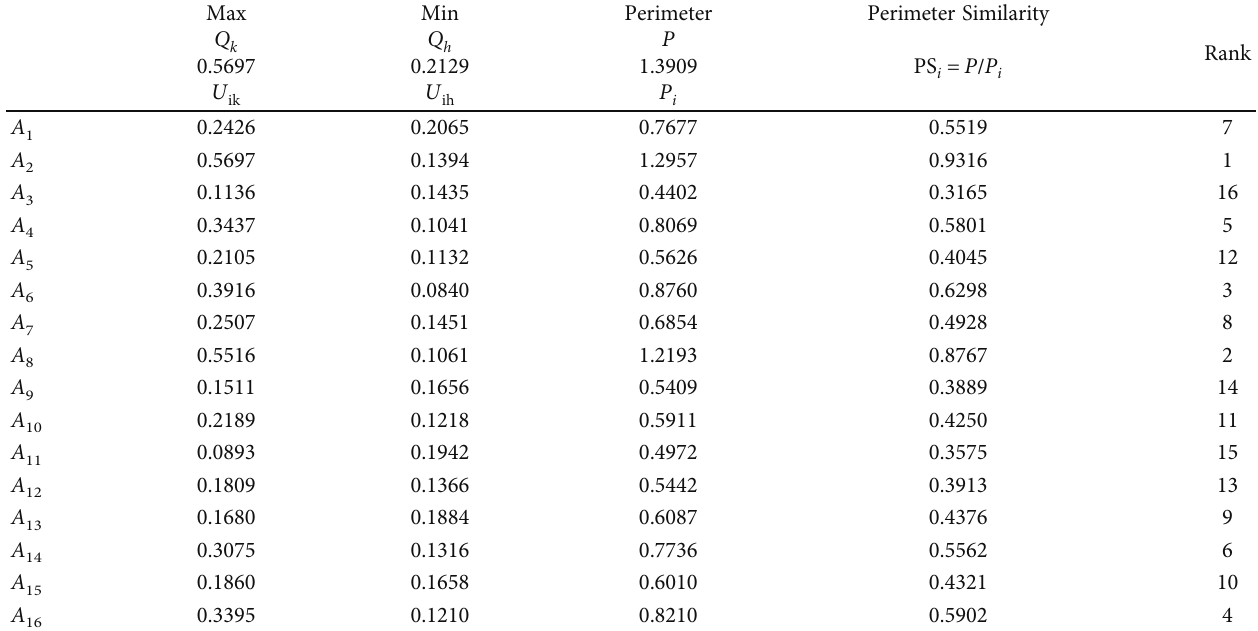
Table 8: Alternatives ranked according to RAPS